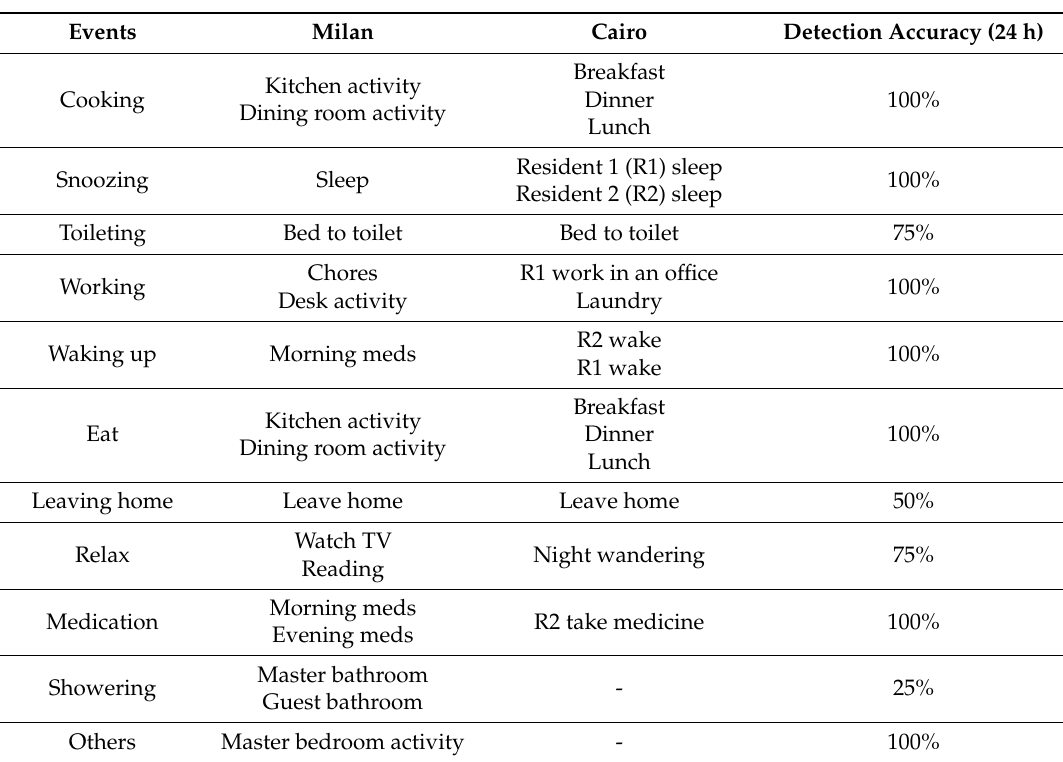
Table 2. The tested and detected events in CASAS